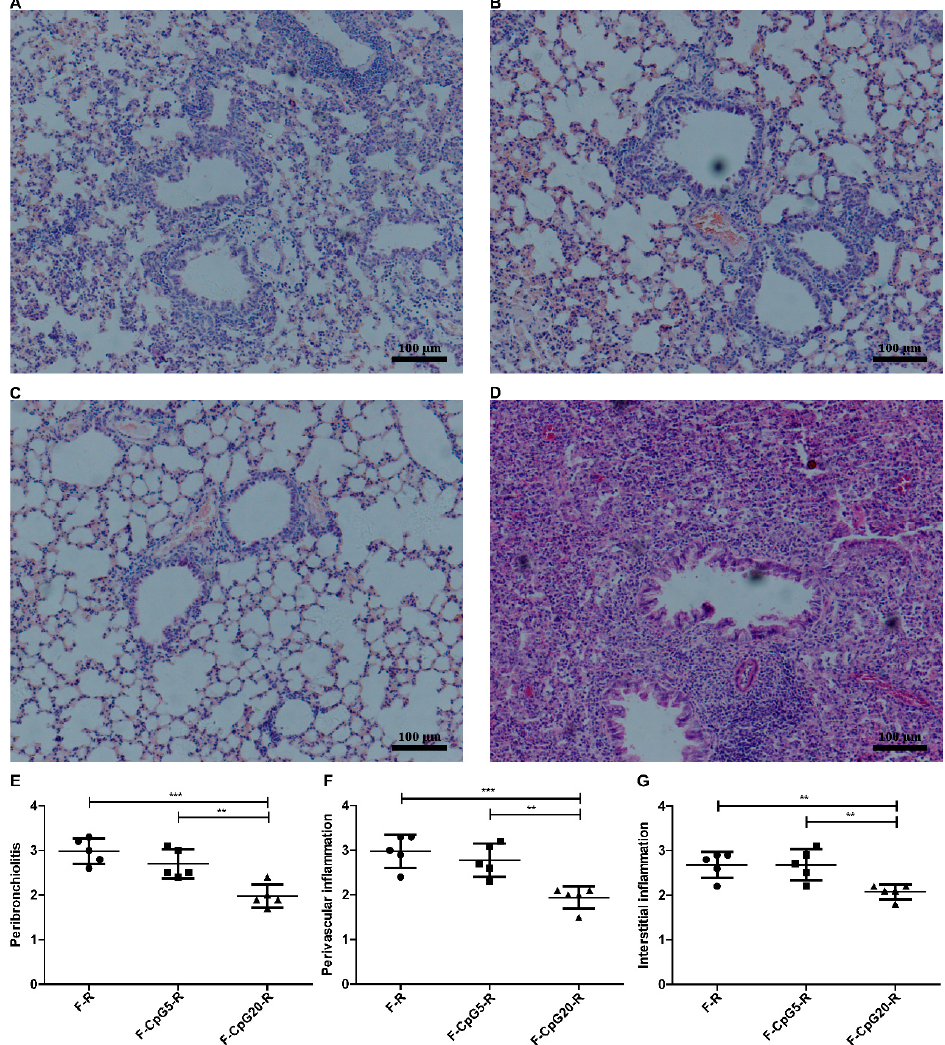
Figure 4. Histopathology analysis of Hematoxylin Eosin (H & E) stained lungs from immunized mice after RSV challenge. BALB/c mice ( n = 5) were immunized 4 times via i.m. route with either pVAX1-F (30 μ g/dose/mouse), pVAX1-CpG5-F (30 μ g/dose/mouse), or pVAX1-CpG20-F (30 μ g/dose/mouse). In addition, the mice, immunized by single injection of FI-RSV (equivalent of 1 × 10 6 PFU RSV/mouse), was used for the analysis of ERD. The vaccinated mice were intranasally challenged with RSV of 1 × 10 6 PFU at 14 days after the last DNA immunization or 21 days after FI-RSV immunization. The lung tissues ( A – D ) from F ( A ); F-CpG5 ( B ); F-CpG20 ( C ); or FI-RSV ( D ) immunization mice were collected at day 4 post RSV challenge and prepared for light micrographic analyses of pulmonary histopathology by H & E stain. The H & E stained lungs were scored ( E – G ) for inflammation with semi-quantitative scale from 0 to 4 (0 = absent and 4 = maximum/severe); including the inflammation scores of the peribronchiolar region ( E ); the perivascular region ( F ); and the interstitial region ( G ). Data showed mean ± SD, analyzed by one-way ANOVA with non-parametric test, and each point of the data represented an individual animal. ** p < 0.01, *** p < 0.001. F: pVAX1-F; F-CpG5: pVAX1-F-CpG5; F-CpG20: